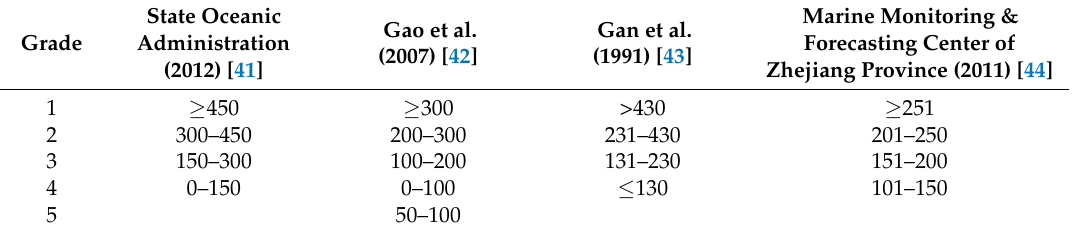
Table 1. Storm surge disaster intensity division based on storm surge elevation (unit: cm).